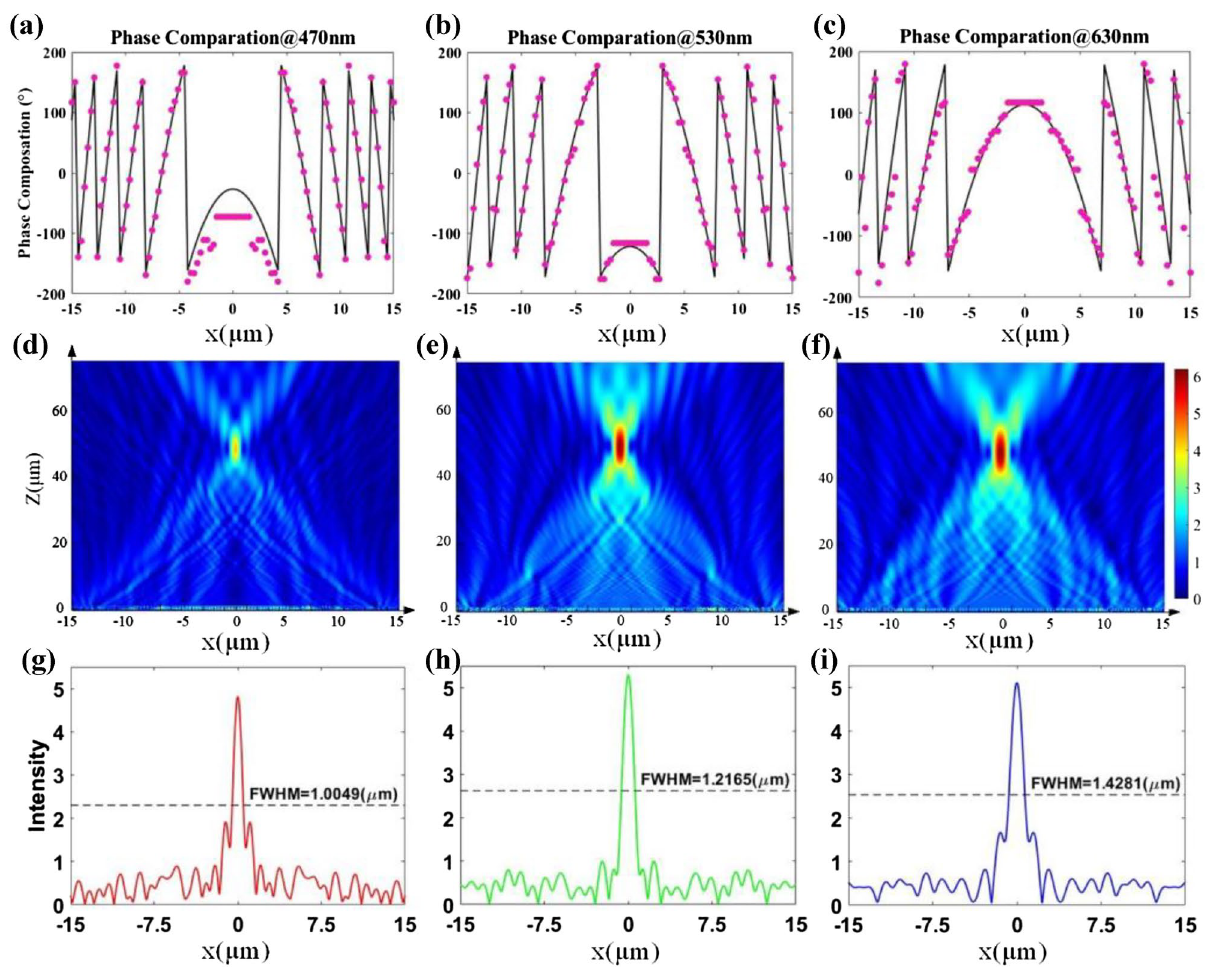
Figure 7. ( a – c ) Comparisons of the target phase profiles (solid lines) and actual phase profiles (dot lines) of the focusing layer at the wavelengths of 470 nm, 530 nm and 630 nm, respectively. ( d – f ) Simulated electric field intensity distribution of meridional plane at the wavelengths of 470 nm, 530 nm and 630 nm, respectively. ( g – i ) Simulated electric field intensity distribution of focal plane at the wavelengths of 470 nm, 530 nm and 630 nm,